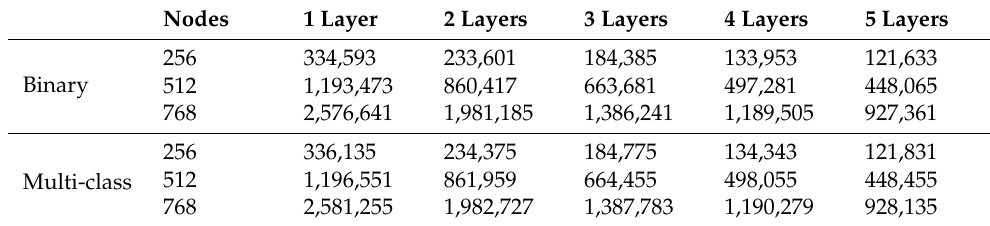
Table 14. The number of parameters of the LSTM model.